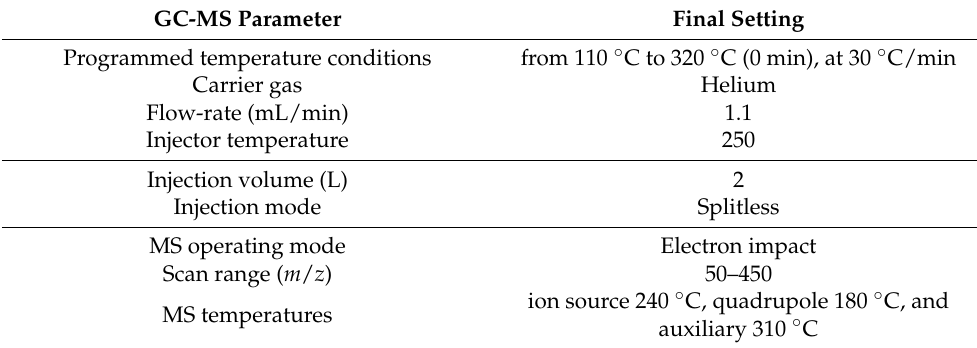
Figure 1. Scheme of the proposed sample treatment. Table 3. GC-MS and HPLC-MS